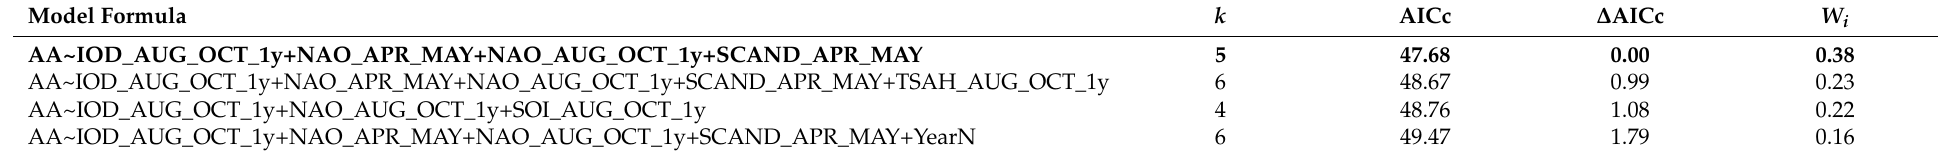
Table A21. Model selection procedure by “all subsets”, according to AICc, from the full model of the relationship between the 15 climate variables and the year, and the overall timing of migration as measured by Annual Anomaly (AA) for the Common Whitethroat Curruca communis caught at Bukowo, Poland, in 1982–2017. Symbols as in Table A19. The best model, discussed in the text, in bold